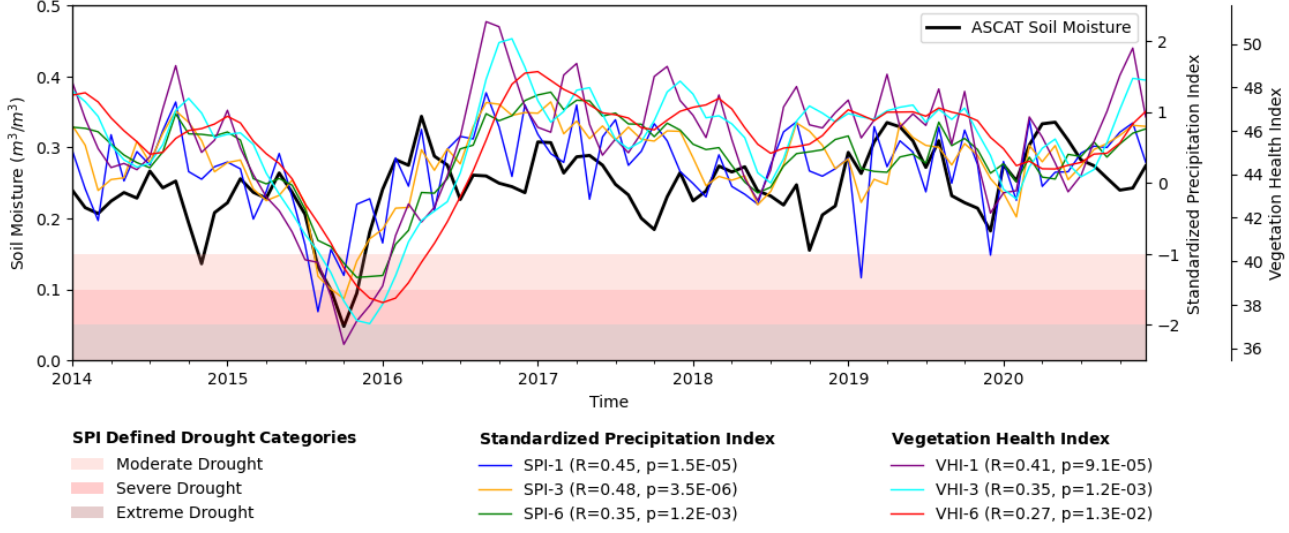
Figure 15. Drought in Papua New Guinea—SPI 1-3-6, VHI-1-3-6, and ASCAT SM averaged over all PNG and plotted as a time series.